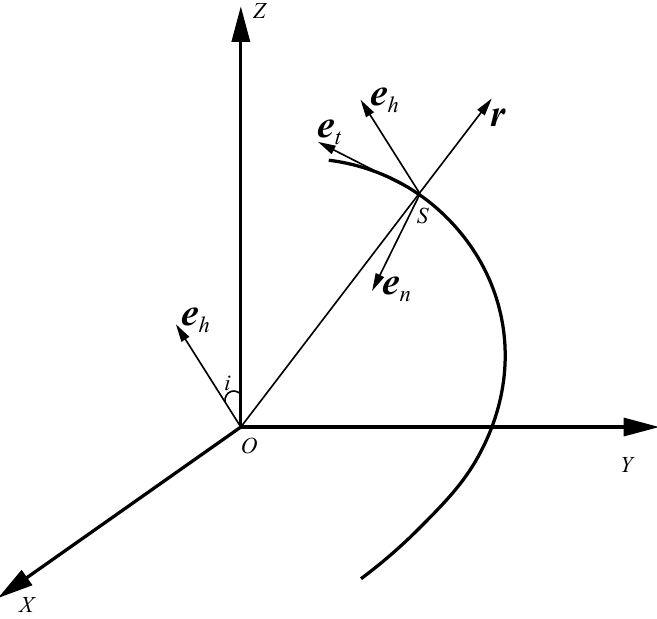
Figure 1. Tangential-normal coordinate